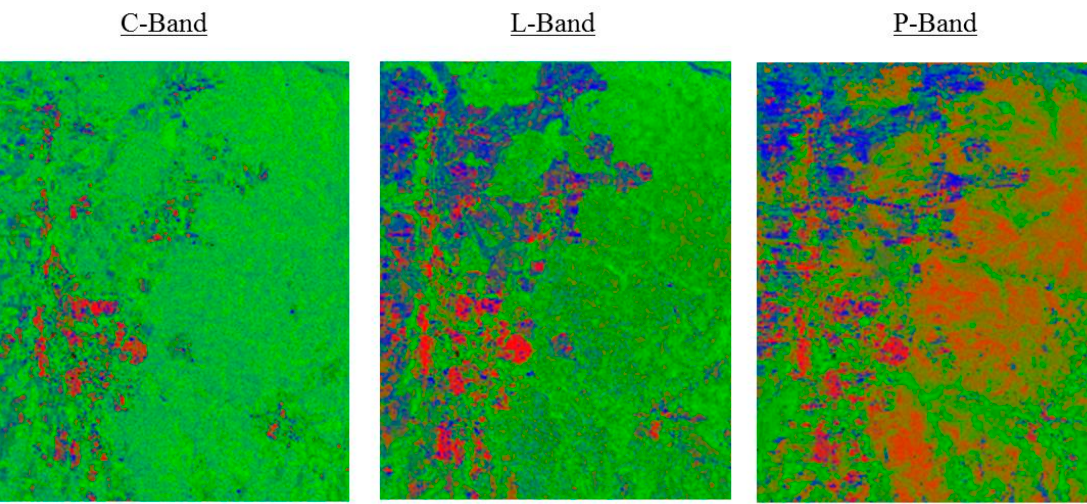
Figure 5. Decomposition results using nonnegative eigenvalue decomposition (NNED) are shown. The original images with three different frequencies are the same as in Figure 3. Color assignments are the same as Figure 3 as well [21].